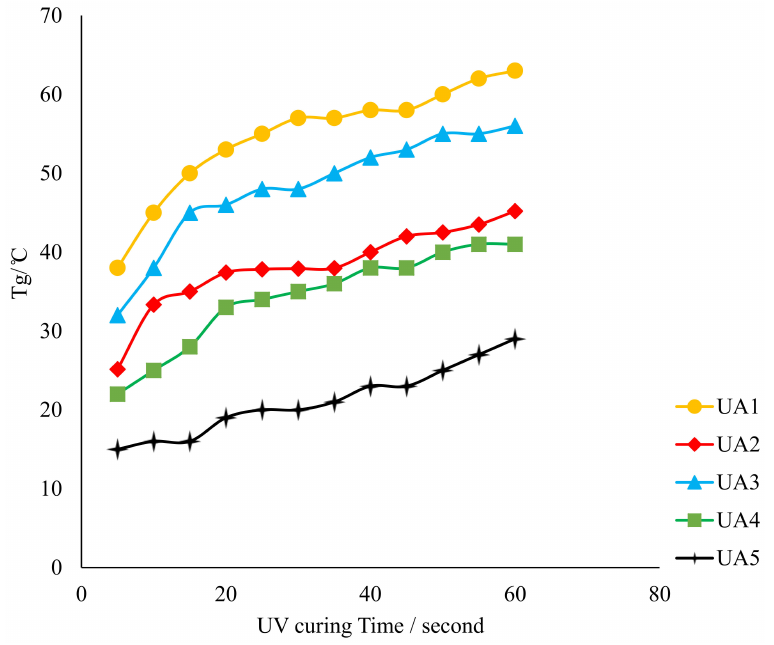
Figure 7. T g of the UA films at different UV curing times.